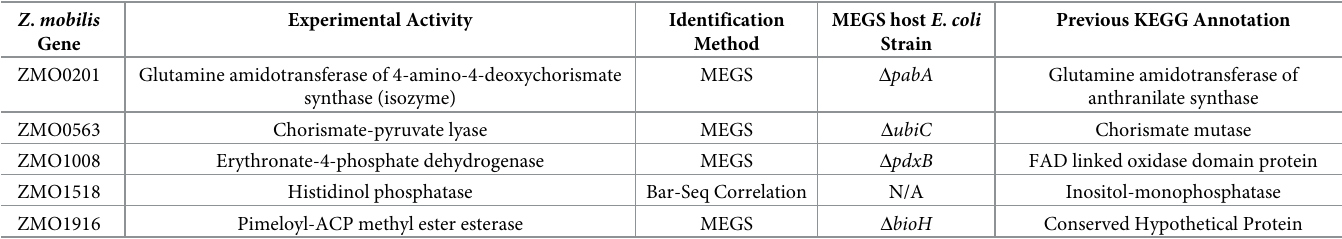
Table 4. Summary of identified